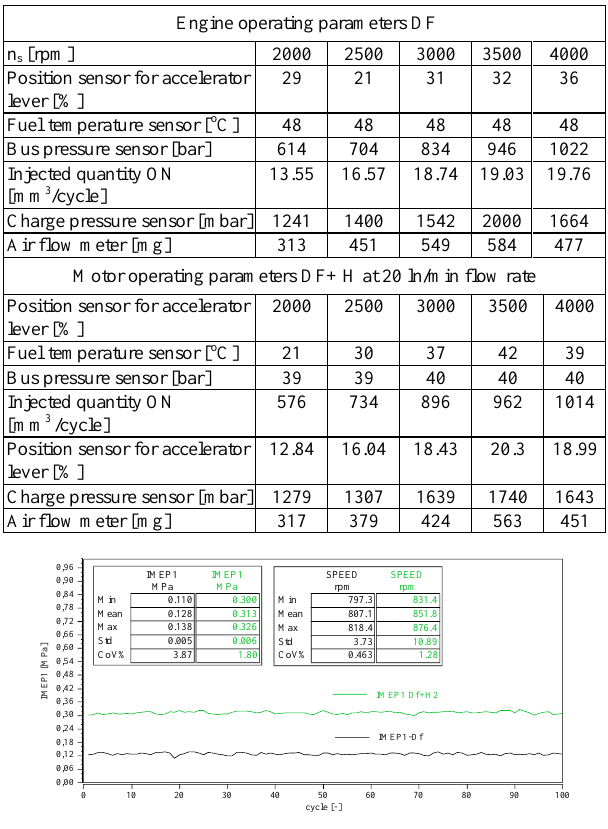
Fig. 4. Mean indicated pressure for 100 subsequent working cycles of the engine powered by diesel oil (black colour) and diesel oil and HHO (green colour) at idling speed; additionally, the tables show minimum, maximum, average values and standard deviation for mean indicator pressure (IMEP1) and engine speed